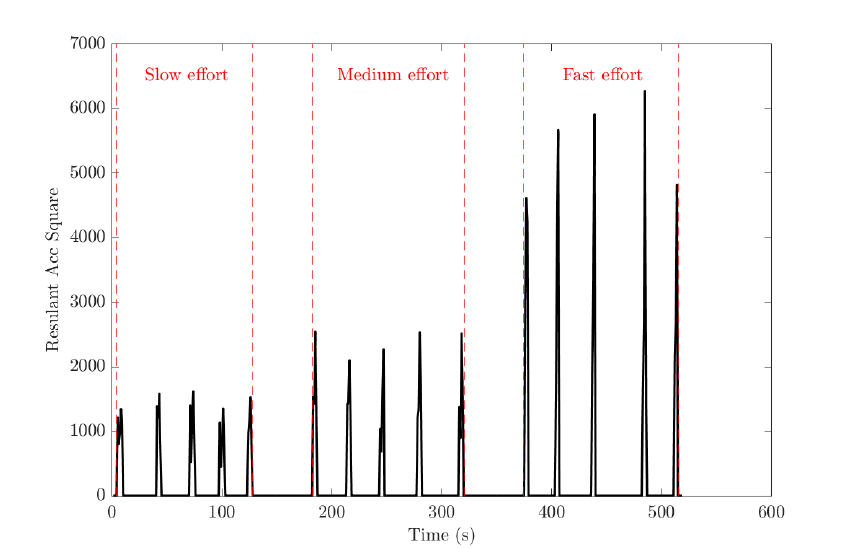
Figure 4. Random sample of a participant’s pre-processed right-foot data with three different 10 m run through efforts (slow, medium,